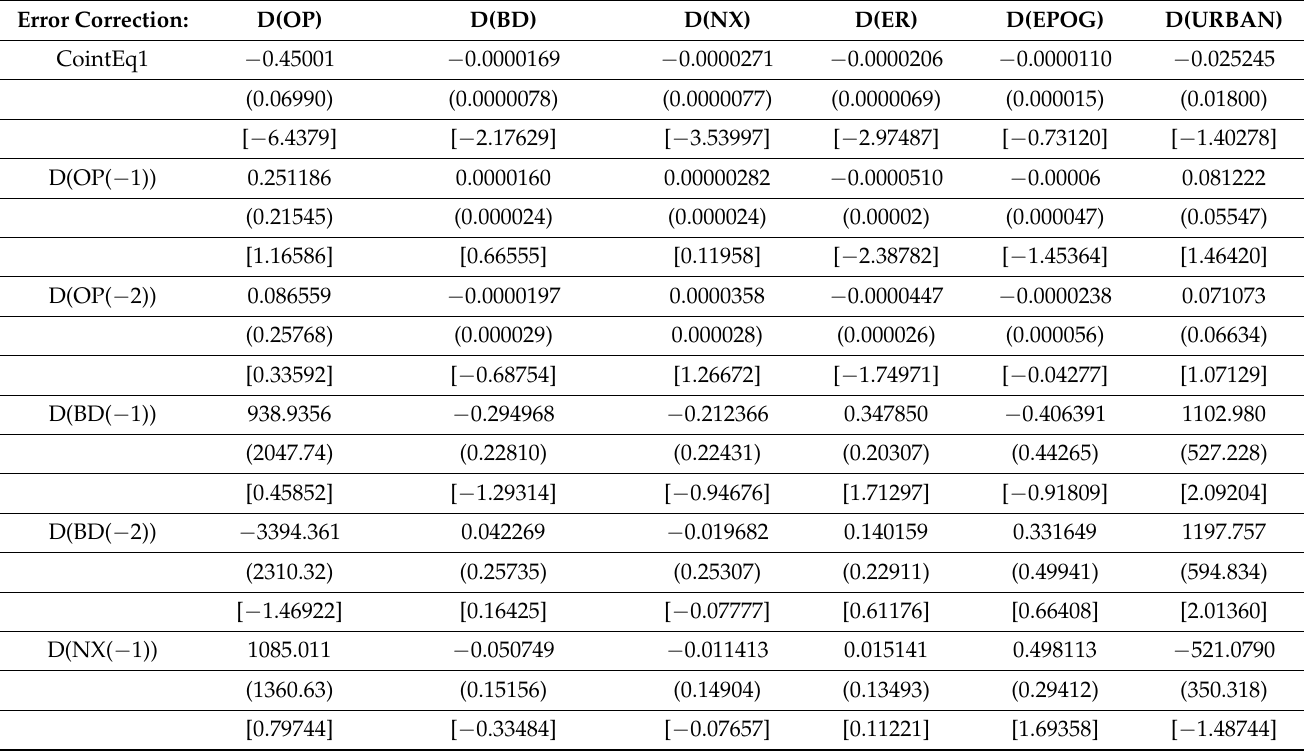
Table A2. Vector error correction long-run estimates (Model